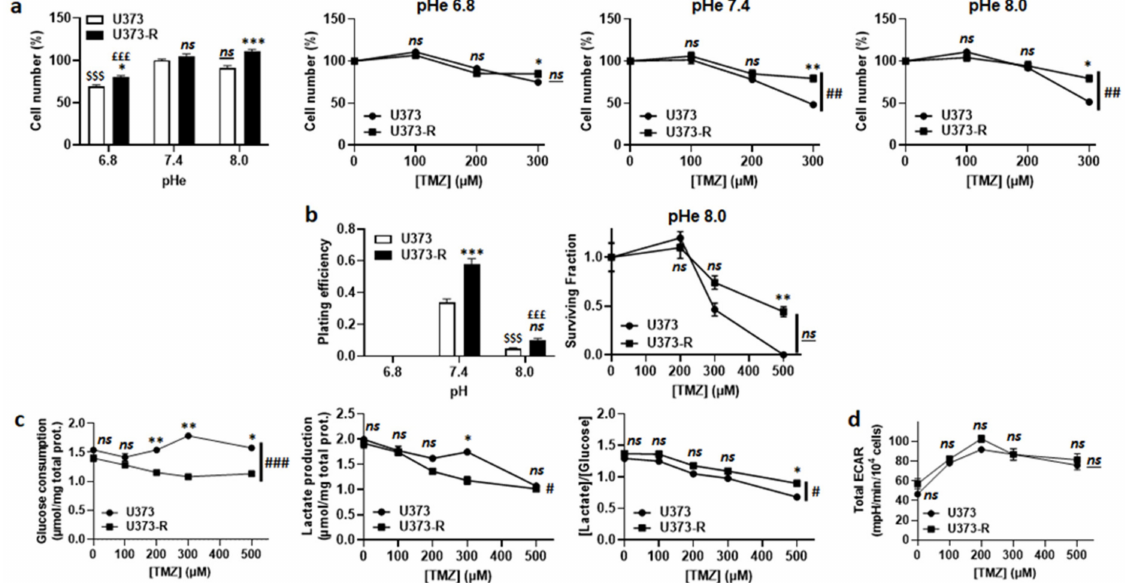
Figure 3. Extracellular pH alkalization increases U373-R sensitivity to TMZ, but resistant cells do not acidify the extracellular milieu. ( a ) Number of U373 and U373-R glioblastoma cells after 72 h of culture at different extracellular pH (pHe) ± TMZ. Shown are vehicle-treated cells at different pHe ( far left ); and the cells at pHe 6.8 ( middle left ), pHe 7.4 ( middle right ), or pHe 8.0 ( far right ) that were treated with increasing concentrations of TMZ ( n = 4 all). ( b ) Clonogenic assays of cells after 72 h of culture at different pHe ± TMZ. Displayed are the plating efficiency of untreated cells ( left ; n = 5–6); and the surviving fraction of cells at pHe 8.0 ( right ; n = 5–6), where the data are normalized to the number of the corresponding vehicle-treated cells. ( c ) Glucose consumption ( left ) and lactate release ( right ) that were measured using an ISCUSflex CMA600 enzymatic analyzer after 72 h of cell culture with increasing concentrations of TMZ. The right graph represents the glycolytic efficiency ([lactate]/[glucose]). All data were normalized to total protein contents ( n = 3 all). ( d ) The cells were pretreated for 72 h with increasing concentrations of TMZ, after which their glycolytic extracellular acidification rates (ECARs) were measured on a Seahorse XF96 bioenergetic analyzer ( n = 17–24). All data are shown as means ± SEM. * p < 0.05, ** p < 0.01, *** p < 0.005, ns: p > 0.05 versus corresponding U373 cells; # p < 0.05, ### p < 0.01, ### p < 0.005, ns: p > 0.05 for whole curve comparison; $$$ p < 0.005, ns: p > 0.05 versus U373 cells at pH 7.4; £££ p < 0.005 versus U373-R cells at pH 7.4; by one-way ANOVA with Tukey’s post hoc test ( a far left , b left) or two-way ANOVA with Sidak’s post hoc test ( a middle left , a middle right , a far right , b right , c , d